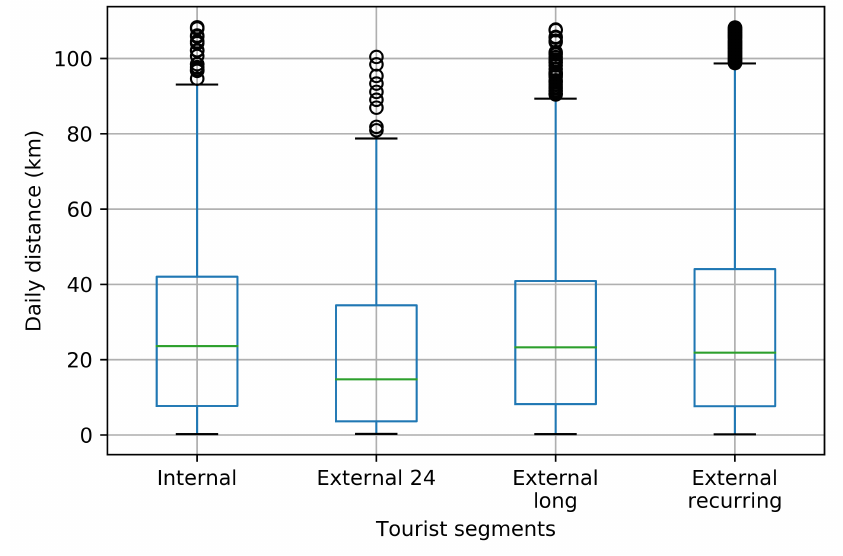
Figure 10. Daily distance